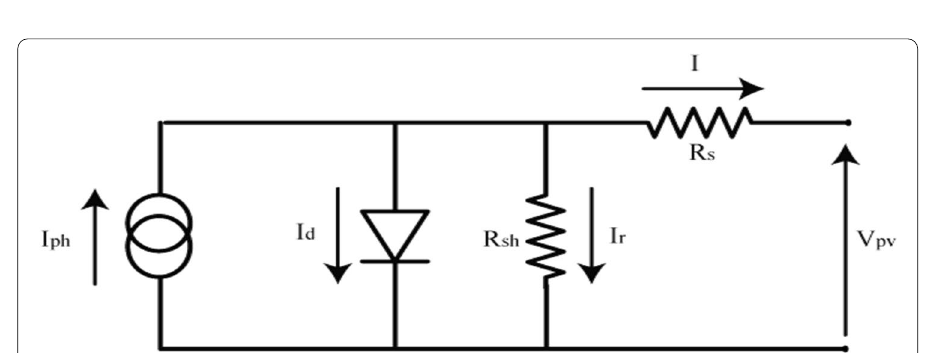
Fig. 2 Solar cell coequal circuit using a single